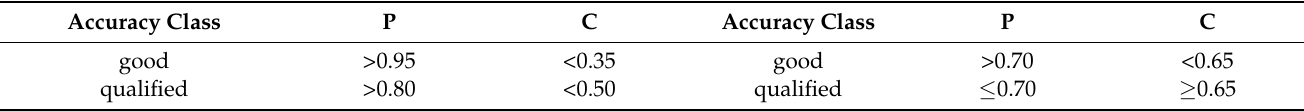
Table 3. Grade Standard of Grey Prediction Accuracy